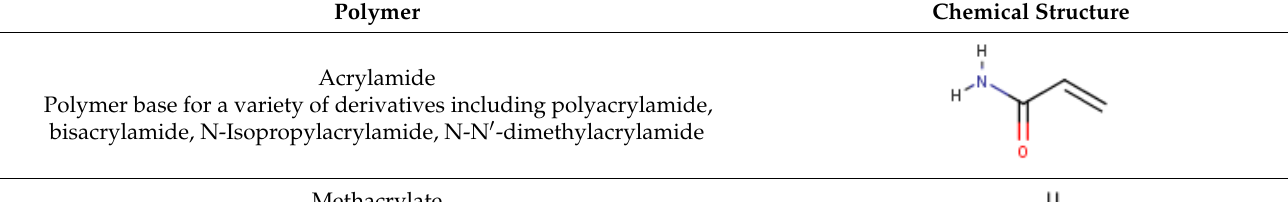
( n = number of units of ethylene glycol)